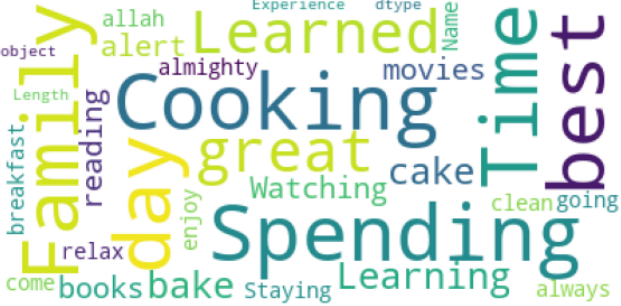
Figure 7. Word cloud representation of best experience.